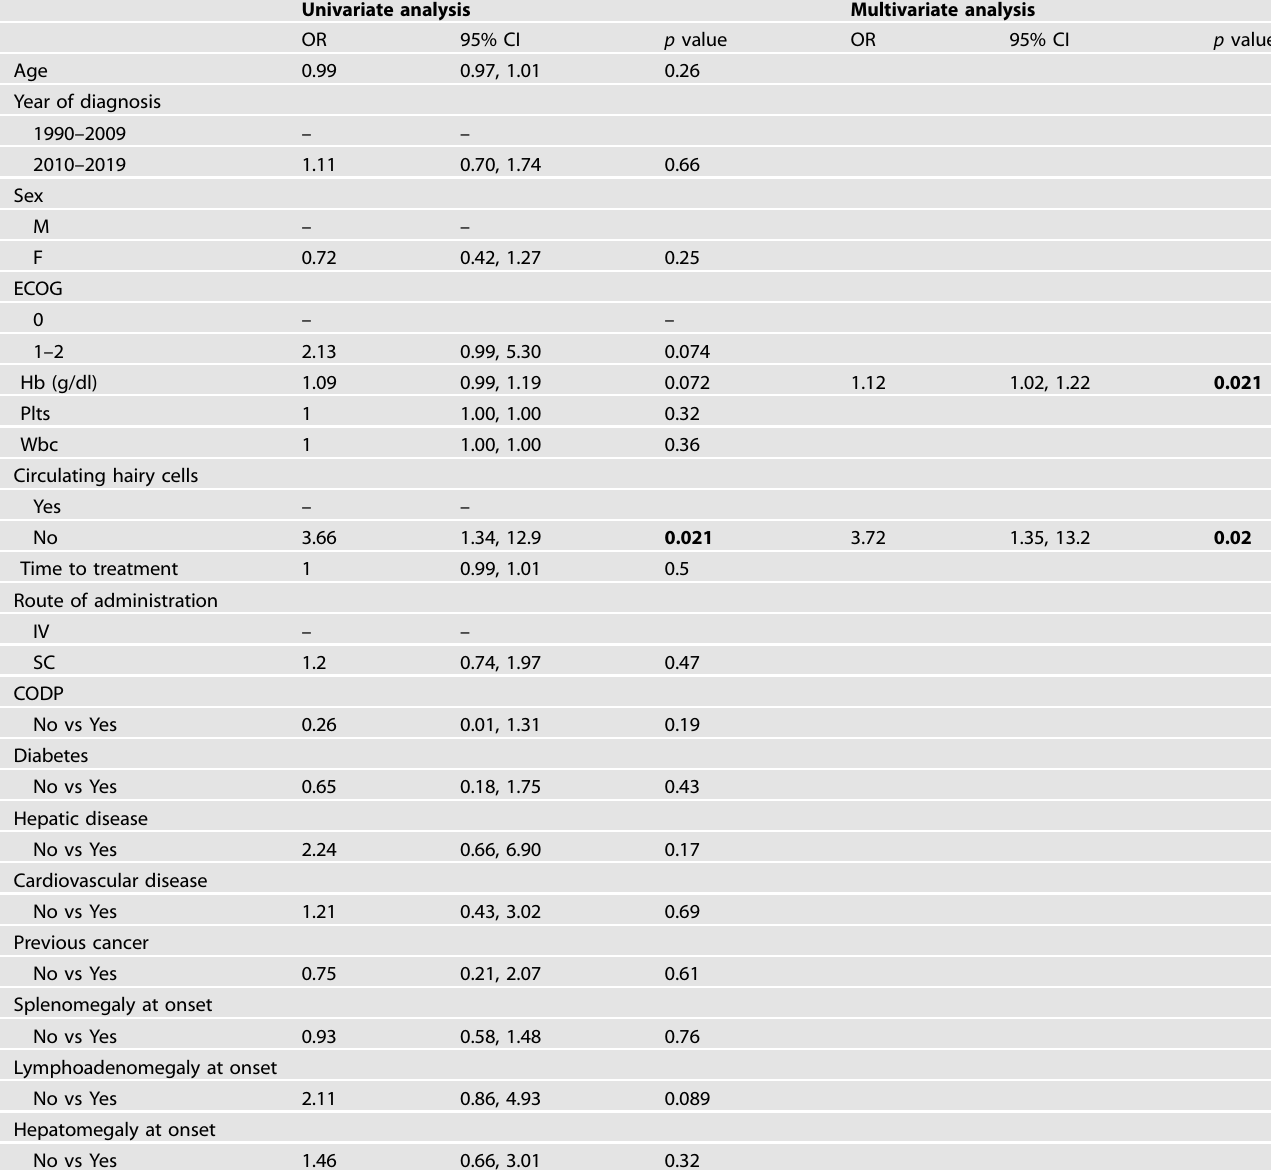
Table 6. Univariate analysis for characteristics associated with CR compared to